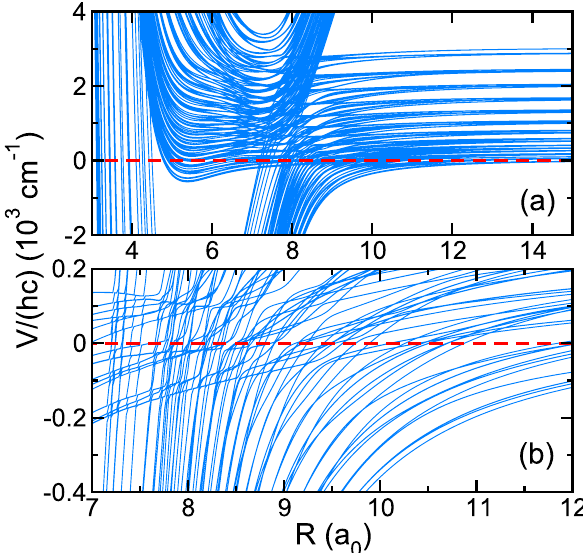
2 and even parity of the 88 Sr with = 25 / 2 are included. The zero of energy is at the energetically-lowest =